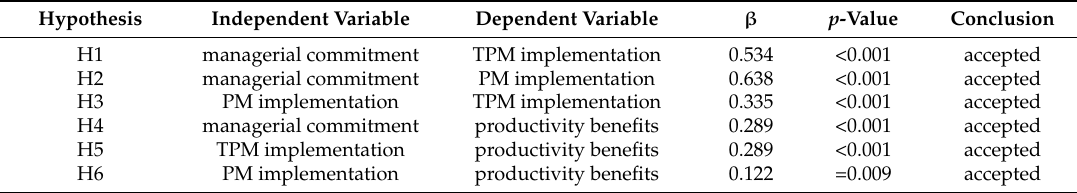
Table 6. Hypothesis validation.